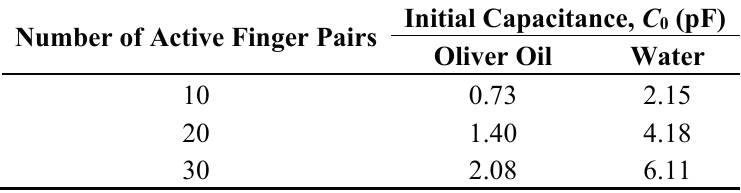
Table 2. Initial capacitance of the sensor with different fluids and different active finger pairs.